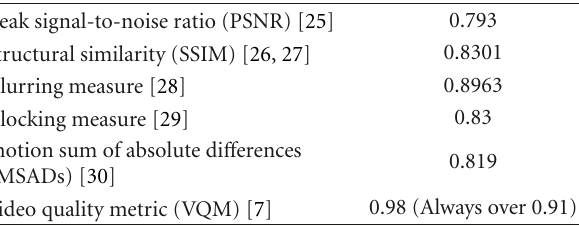
Table 2: Pearson correlation index of the most reliable and famous objective video quality metrics.